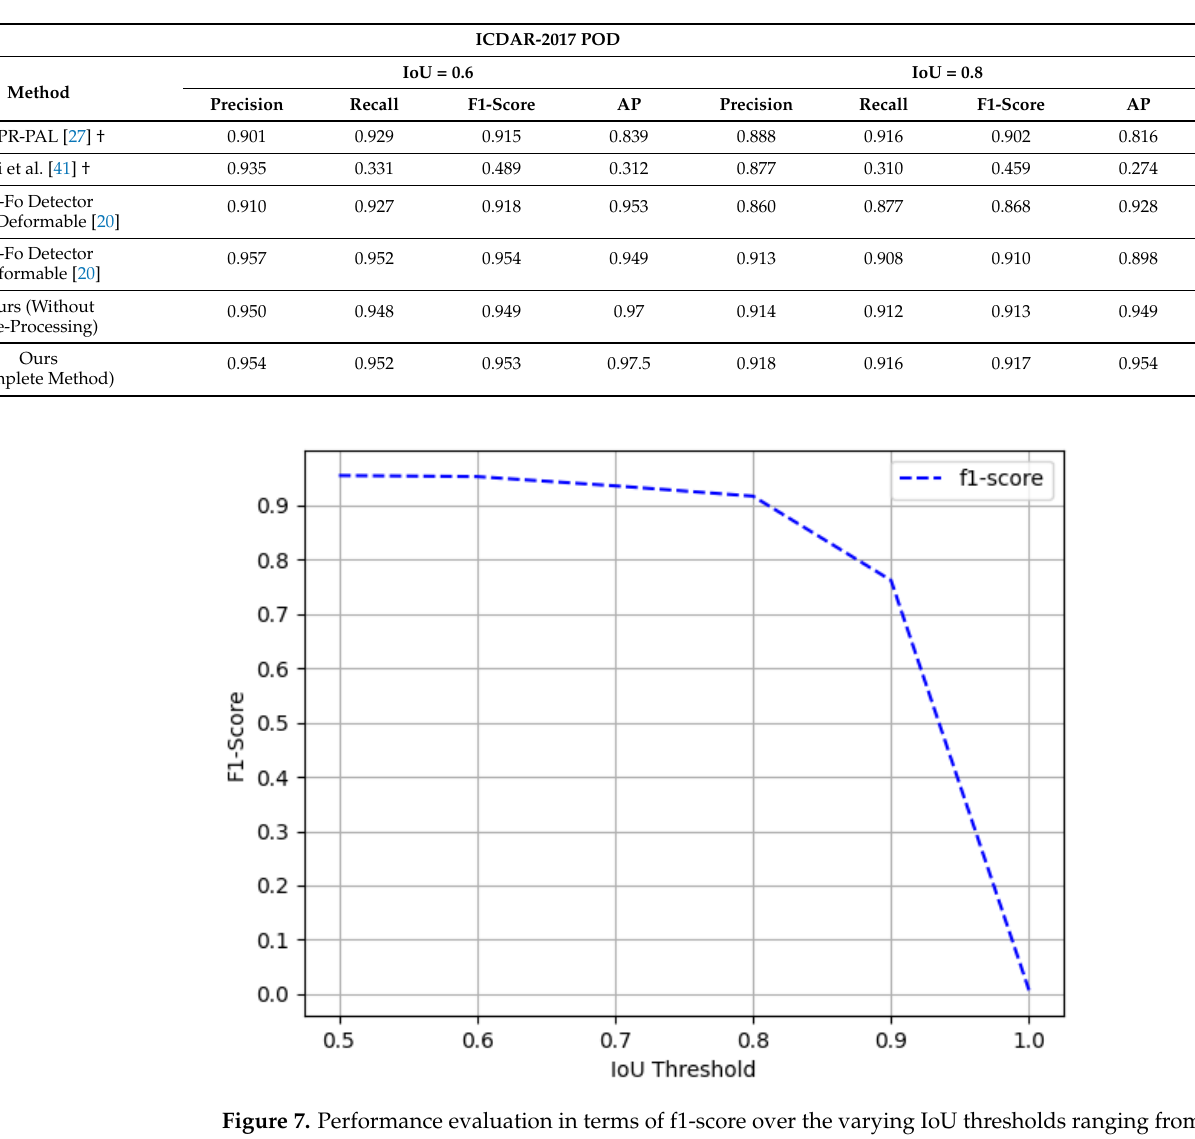
Table 3. Quantitative analysis of the presented work with existing state-of-the-art methods on the ICDAR-2017 POD dataset. † represents the results that are not directly comparable with our method because they are not evaluated on the revised version of the dataset.